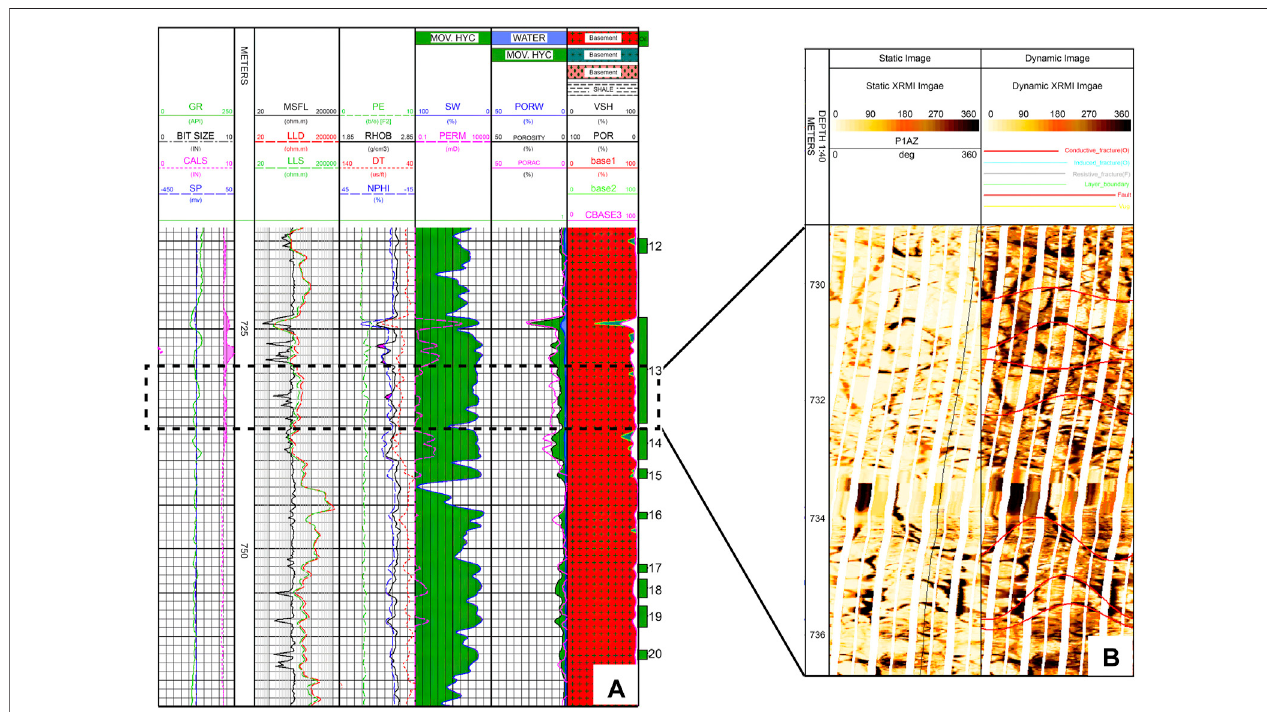
FIGURE 3 | (A) Well log interpretation of well Baobab C-2. (B) Image log of well Babab C-2 (729 – 737 m).